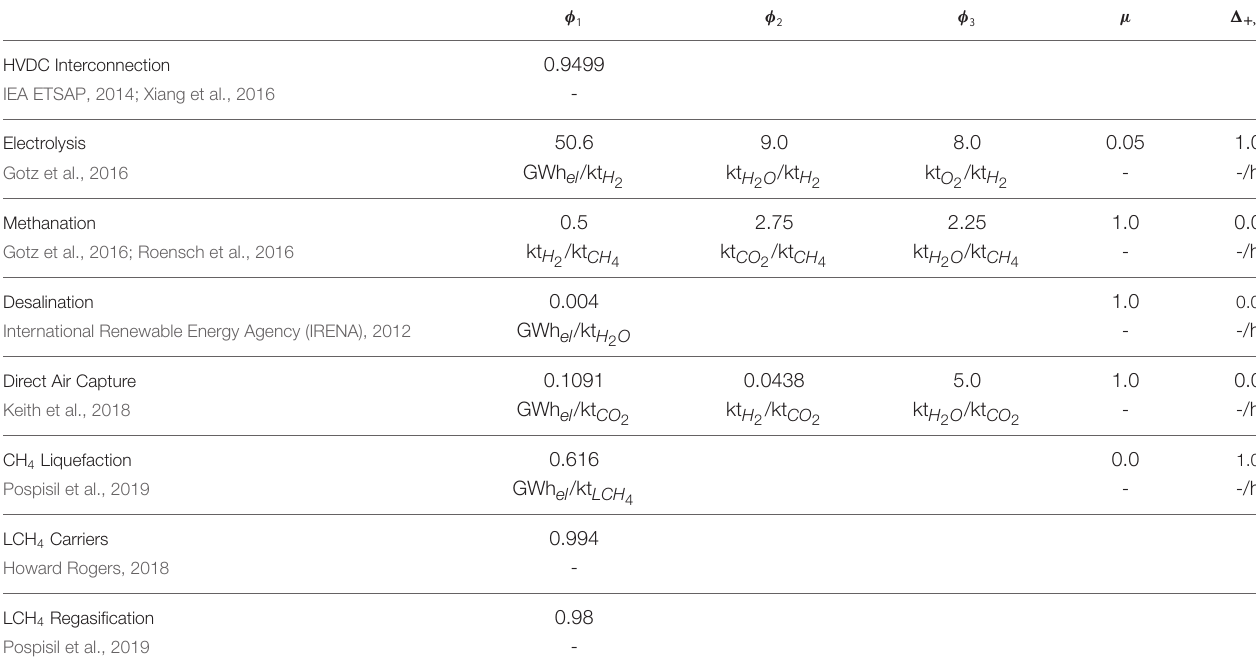
TABLE 1 | Technical parameters used to model conversion